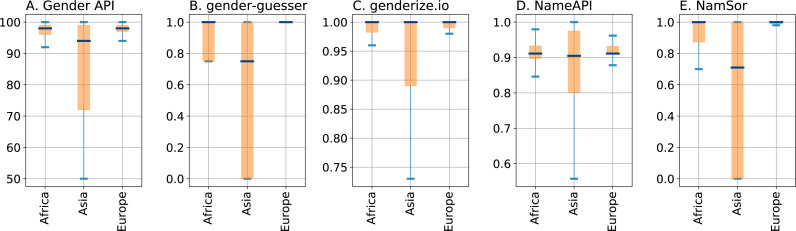
Boxplots depicting quartiles for the confidence parameters of the gender inference services, split by geographical regions Africa, Asia, and Europe as returned by NamSor’s origin API.Panels (A), (B), (C), (D), and (E) display parameters accuracy of Gender API, self-constructed confidence of gender-guesser, probability of genderize.io, confidence of NameAPI and scale of NamSor, respectively. The bottom and top of the colored boxes mark the first and third quartiles of the distribution; the line in the middle of the boxes indicates the median; the ends of the whiskers correspond to the lowest and highest data points within 1.5 interquartile range.